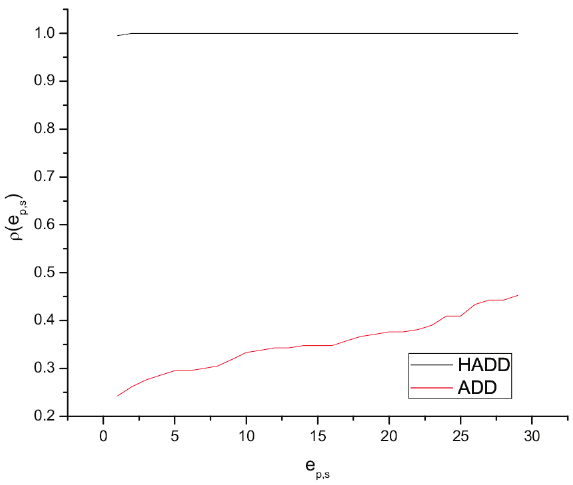
Figure 6. Performance profiles for the HADD and ADD methods regarding the number of function evaluations